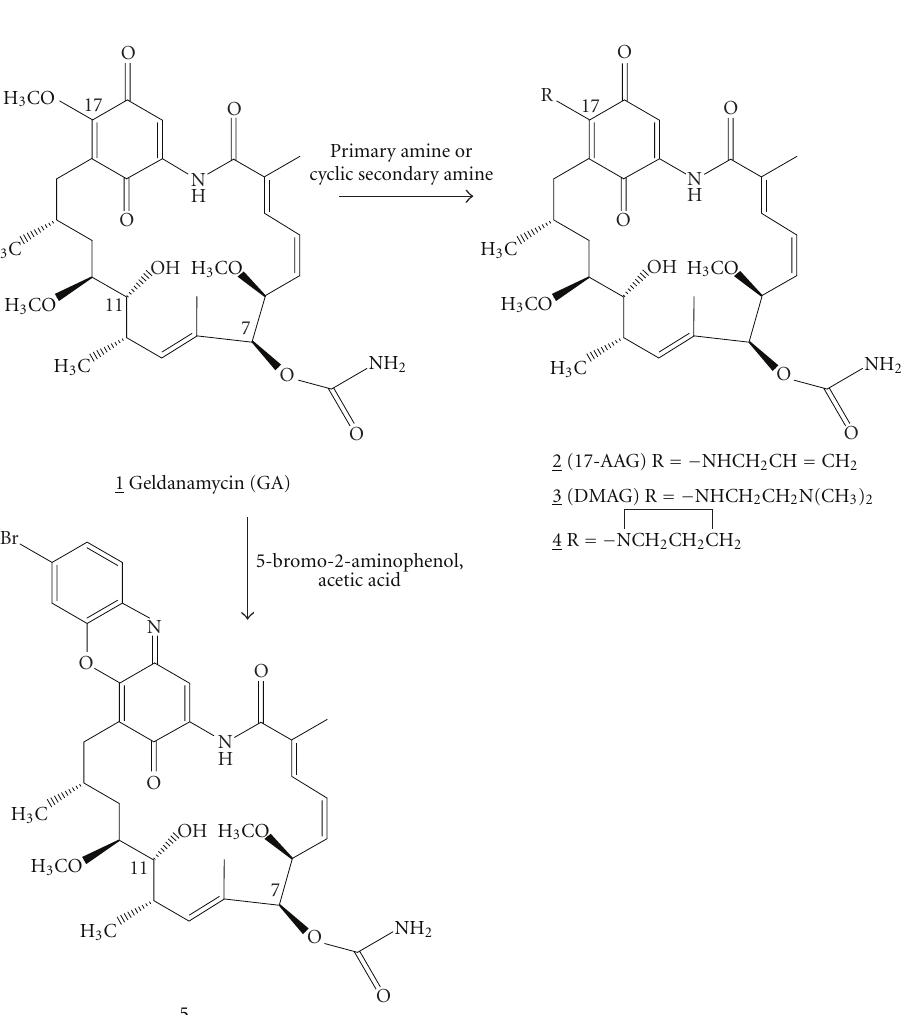
Figure 1: Geldanamycin (GA) chemical structure and structures and synthesis of four